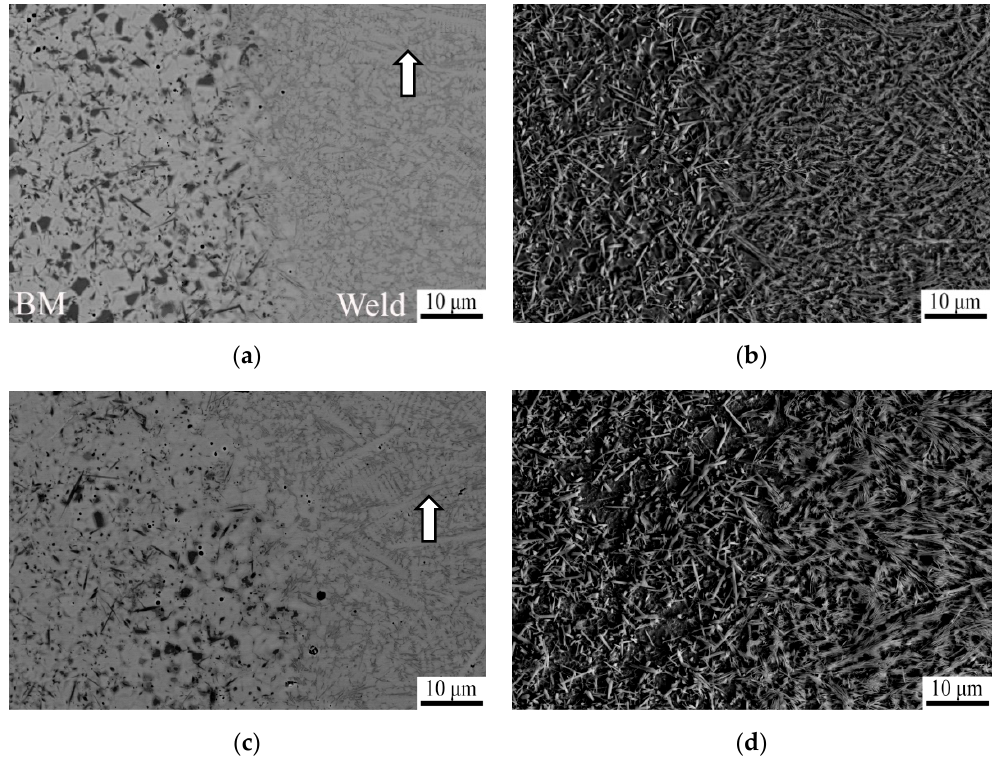
Figure 4. SEM images of the Ti-15%Mo/TiB composite microstructure at the border between the welds and base material (BM) obtained at room temperature (without pre-heating) ( a , b ) or at 600 °C ( c , d ); ( a , c ) unetched and ( b , d ) etched surfaces.